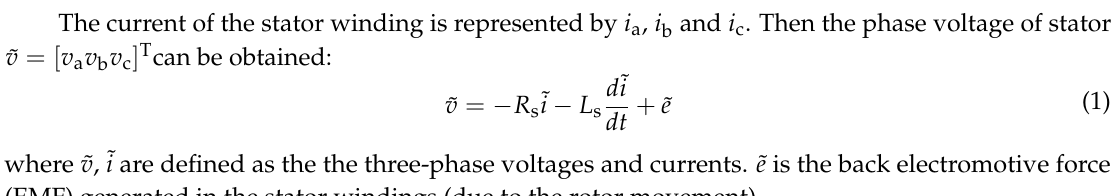
Figure 1. Structure of idealised three-phase